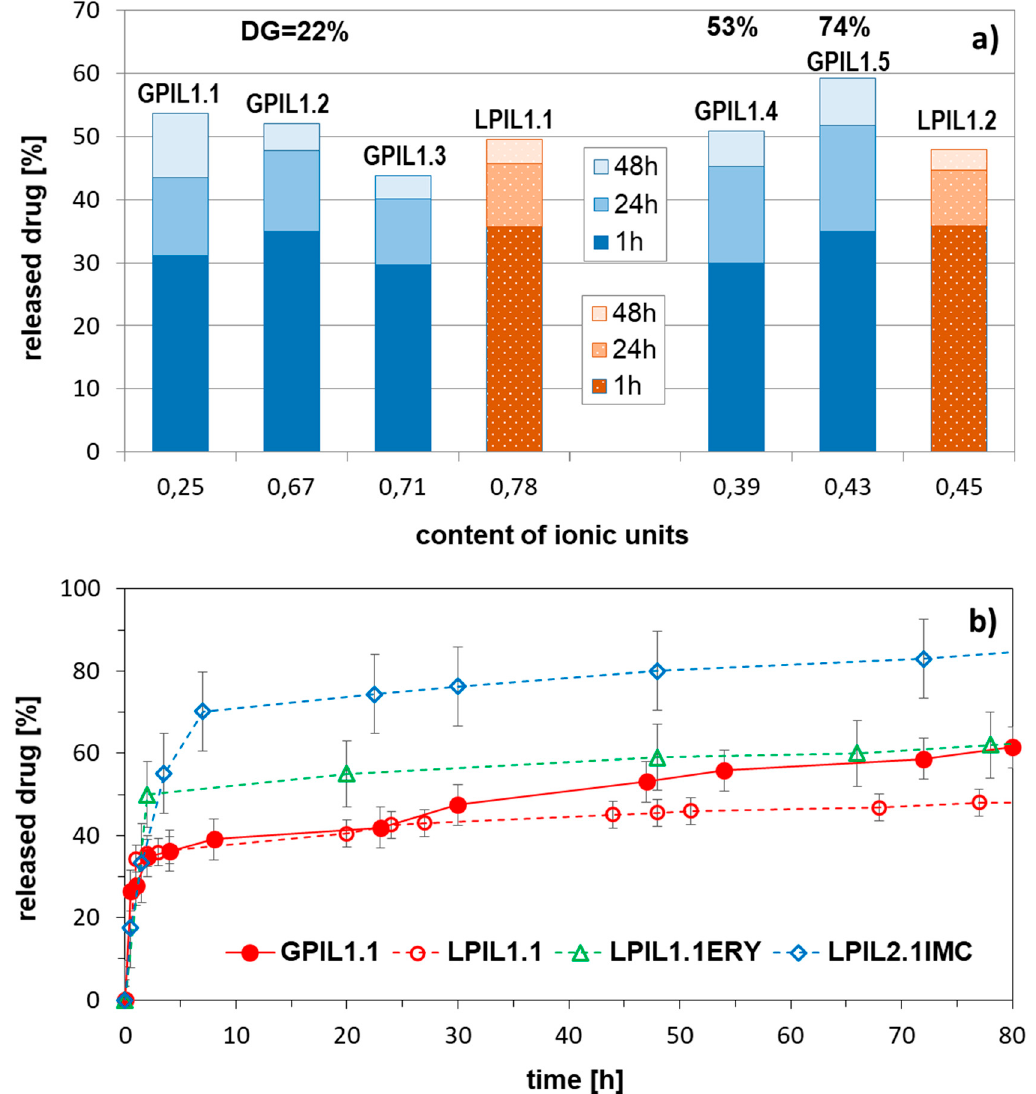
Figure 2. Amount of drug released after 48h in correlation with polymer topology (GPIL vs. LPIL), grafting degree (DG = 22–73%), and content of hydrophilic fraction ( a ), and release profiles of salicylate (GPIL1.1, LPIL1.1) and nonionic drugs (ERY, IMC) ( b ) in PBS at pH = 7.4 and 38 °C.